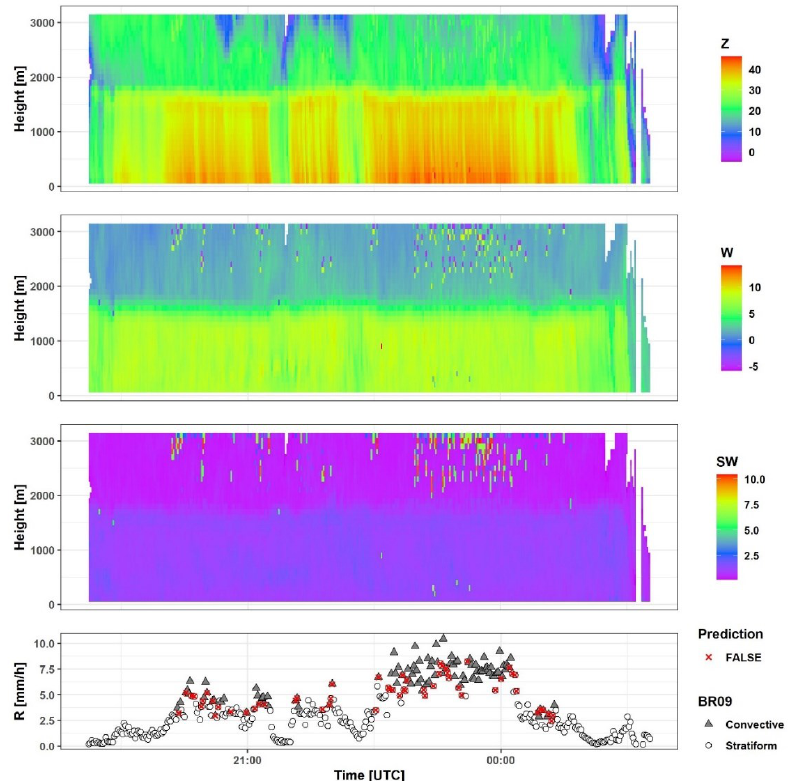
Figure 8. MRR and disdrometer data for event 204. The upper three panels represent the MRR measured values of reflectivity Z (dBZ), Doppler velocity W (m/sec), and spectral width SW (m/sec) respectively. The last panel represents rain intensity R (mm/h) as measured by the